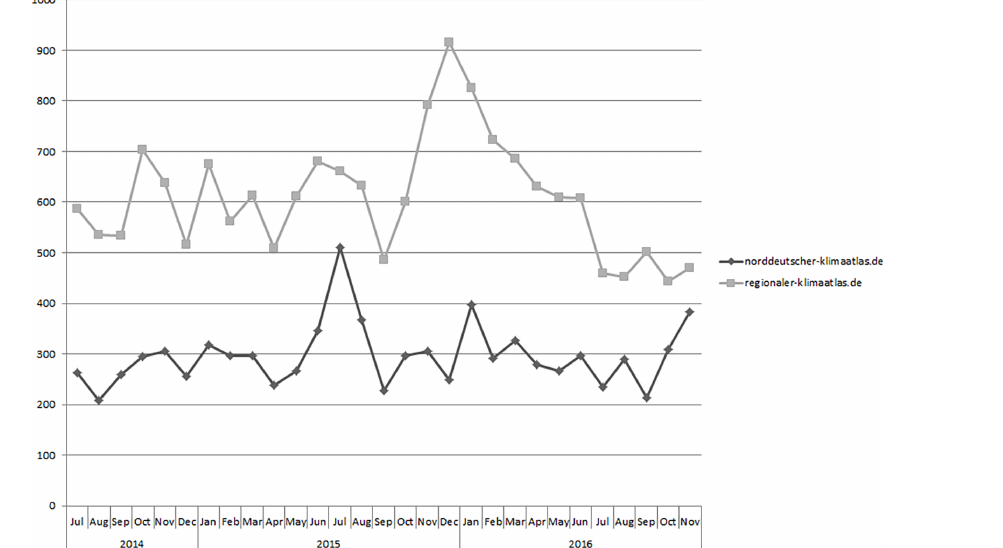
Figure 4. Numbers of visitors at northern German climate atlas (black) and regional climate atlas